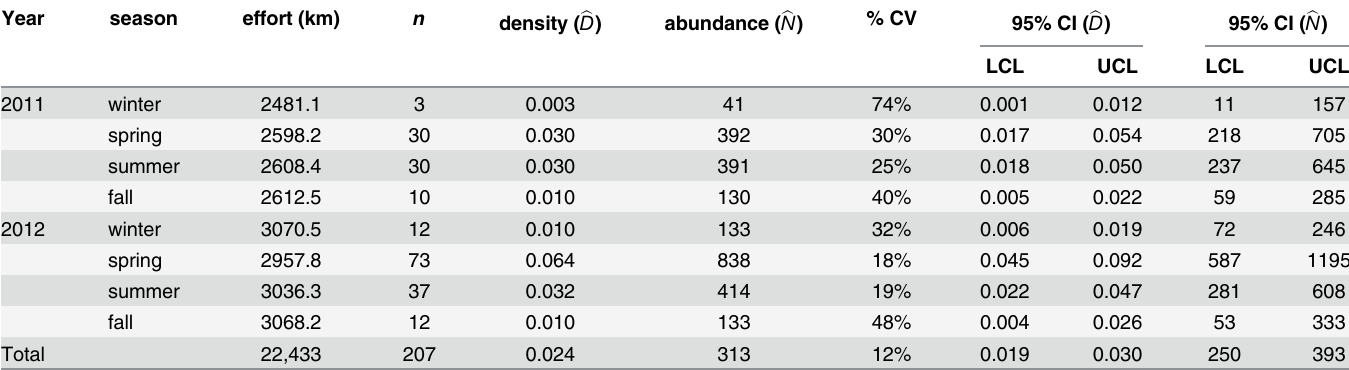
Table 1. Summary of combined aerial survey effort (km), the number of sea turtles sighted ( n ), seasonal estimates of sea turtle density (turtles/ km 2 ) and abundance with 95% confidence intervals for each estimate including lower and upper confidence limits (LCL and UCL, respectively). Seasons are defined as winter (December-February), spring (March-May), summer (June-August), and fall (September-November).